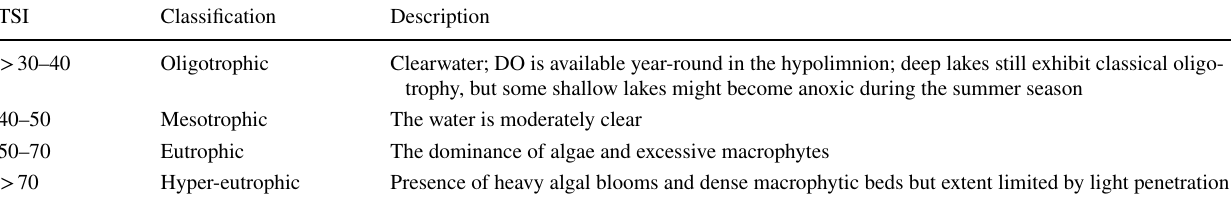
Table 1 Carlson’s trophic state classification criteria